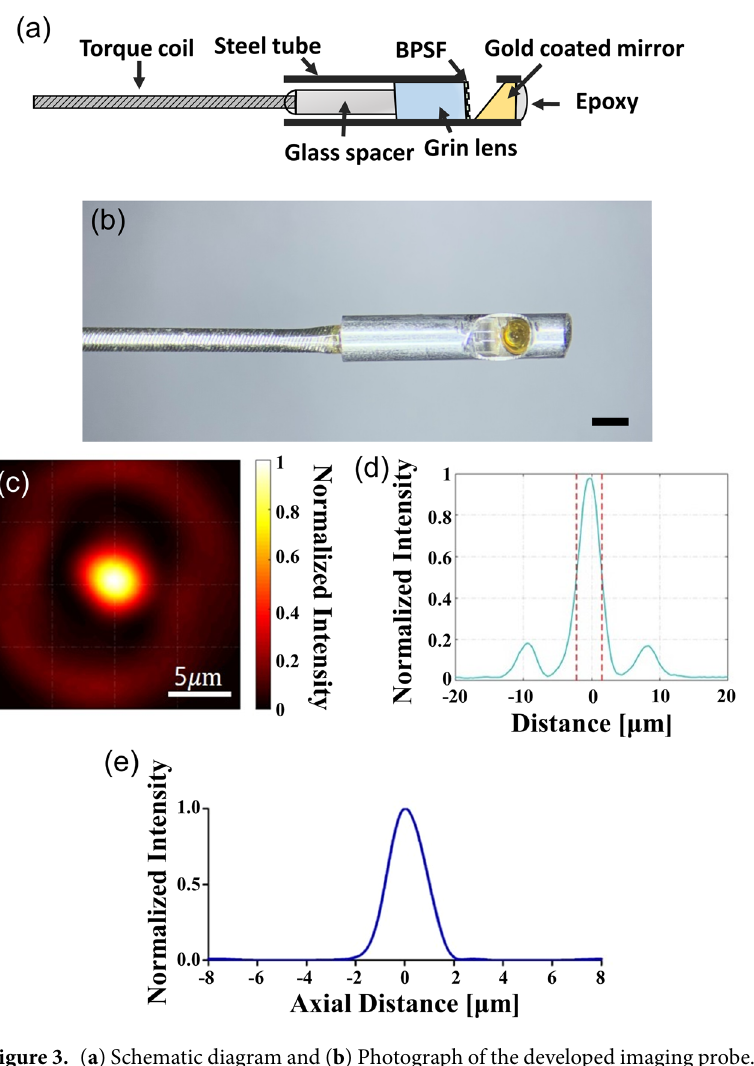
Figure 3. ( a ) Schematic diagram and ( b ) Photograph of the developed imaging probe. Scale bar, 1 mm; ( c ) Two-dimensional transverse PSF of the focused imaging system; ( d ) Cross-sectional profile of the PSF; ( e ) Normalized axial profile of a reflecting surface.